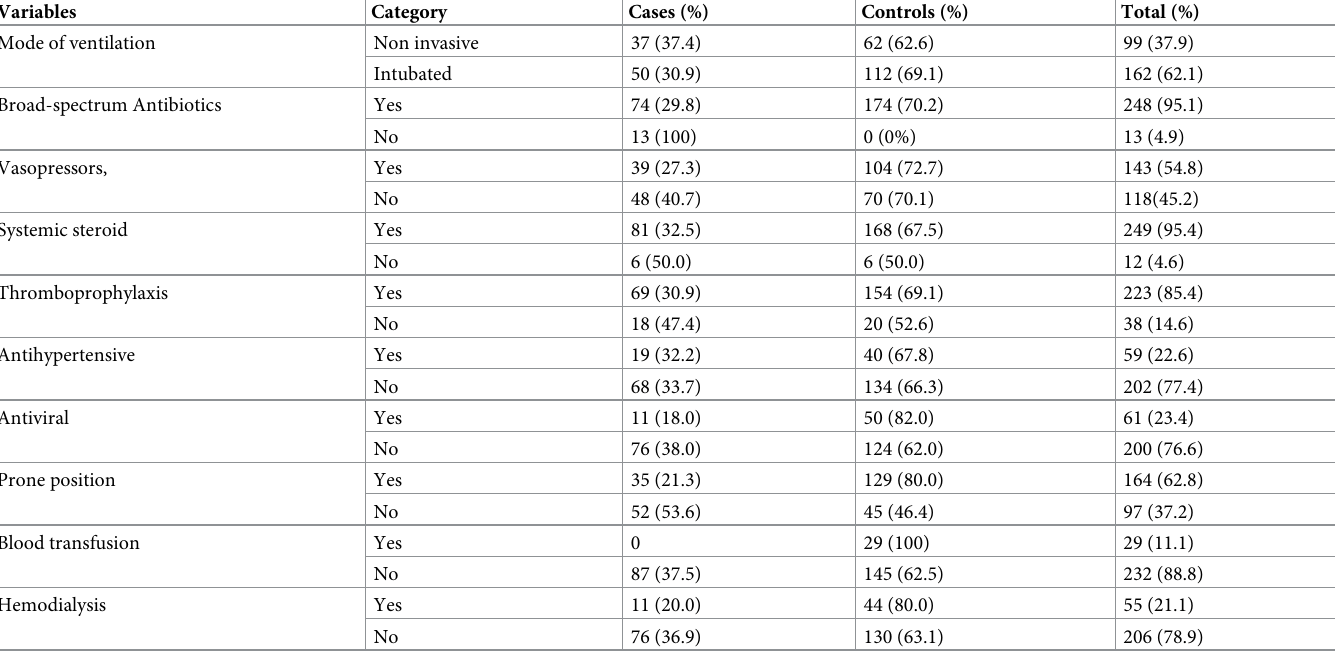
Table 4. Treatment at ICU admission among early and late mortality of ICU admitted COVID-19 at Millennium COVID care center, Addis Ababa, Ethiopia 2022 (n =